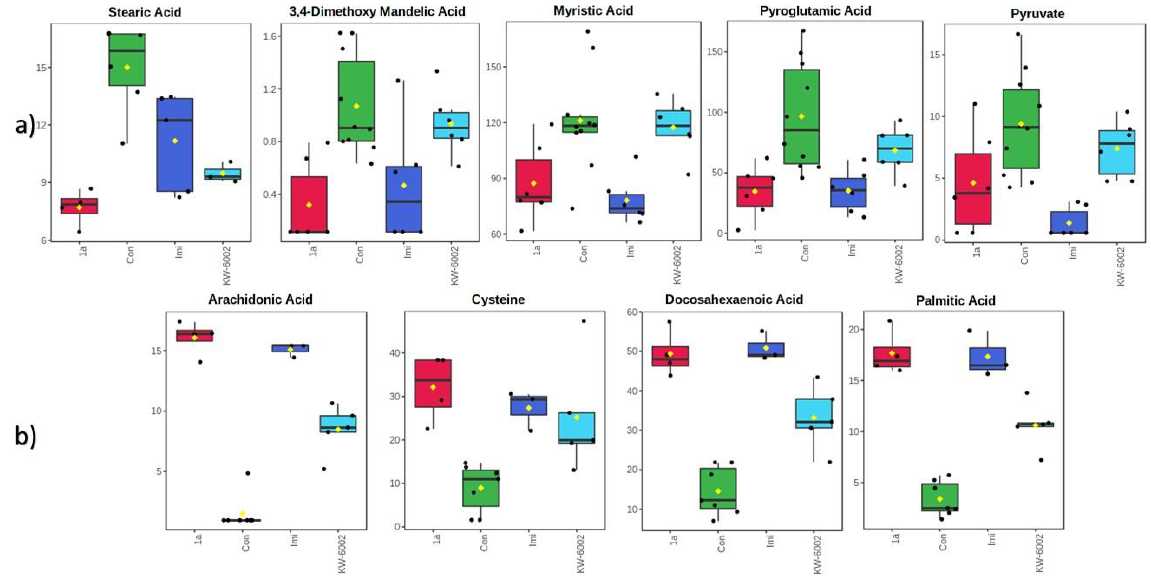
Figure 3. Box-plots illustrating the ( a ) decreased concentrations in serum (stearic acid) and striata (3,4-dimethoxy mandelic acid, myristic acid, pyroglutamic acid, and pyruvate) metabolites and ( b ) the increased concentrations in whole-brain (excluding striata) (arachidonic acid, cysteine, do- cosahexaenoic acid, and palmitic acid) metabolites.